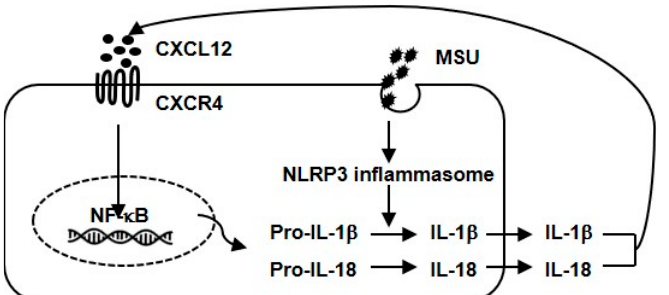
Figure 4. Proposed role of CXCL12 and CXCR4 in uric acid-induced inflammation. Proinflammatory cytokines such as IL-1 β and IL-18 activated by MSU crystals promote CXCL12 and CXCR4 expression in macrophages, reciprocally leading to an augmentation of the inflammatory response by uric acid-induced inflammation.